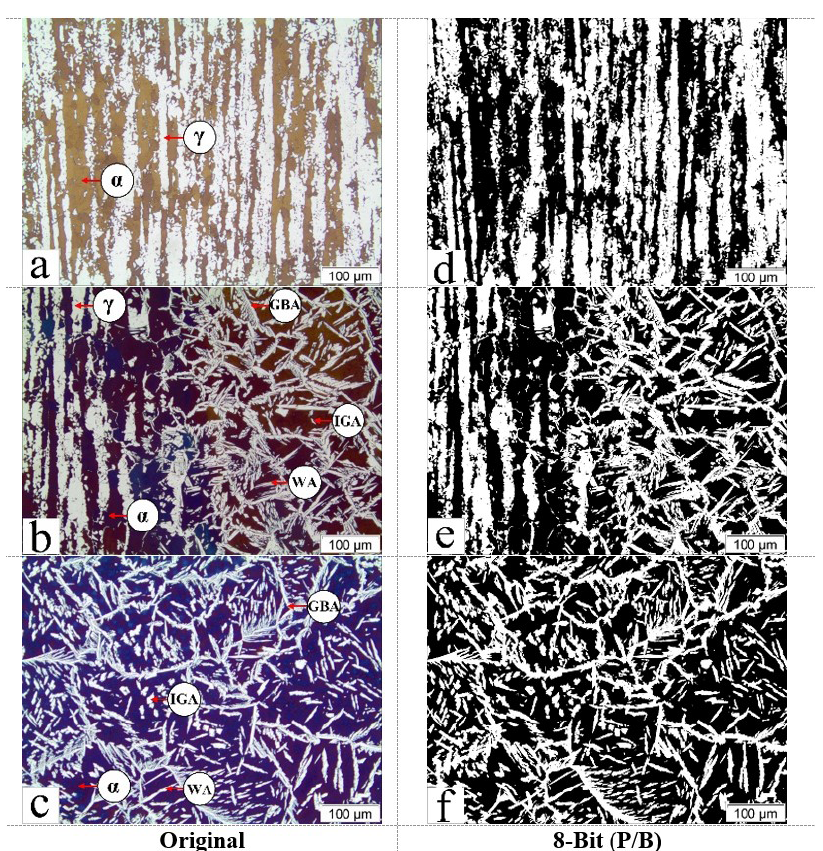
austenite (GBA), Widmanstätten austenite (WA), and